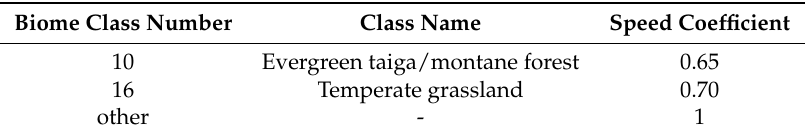
Table 5. Speed coefficients for different biomes (abundant in the area of interest) from the climate and vegetation simulation database of the Stage Three Project [73]. Speed coefficients are derived from the works of White and Barber [74], Frakes et al. [75], Theobald et al.